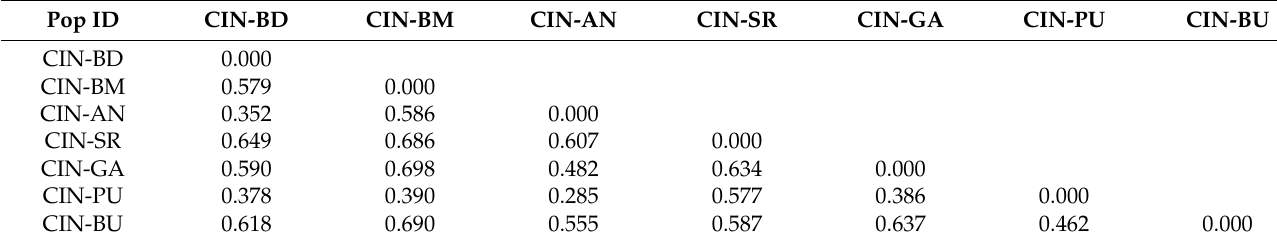
Table 8. F ST distance among the groups of accessions of C. intybus .